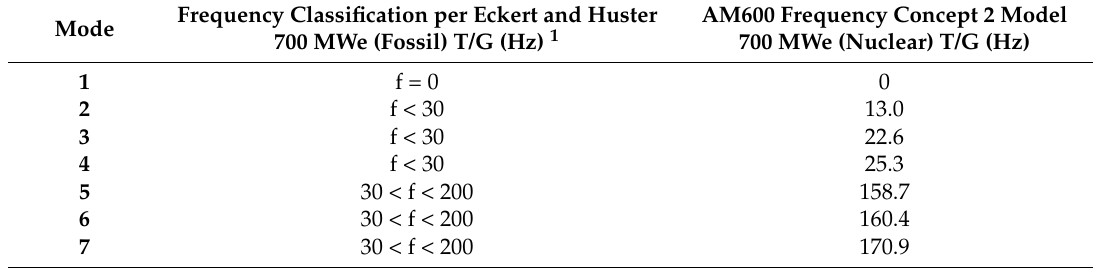
Table 7. Comparison of torsional